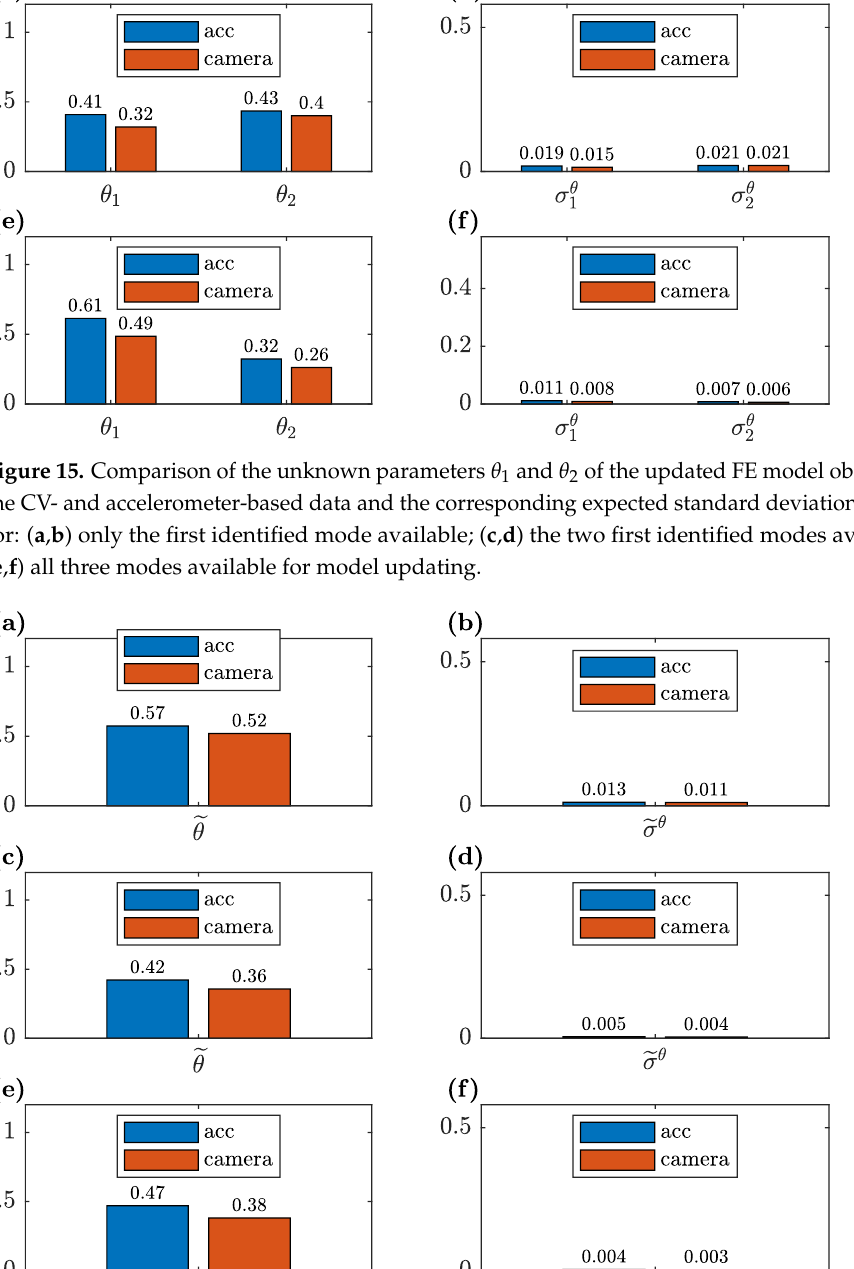
Figure 16. Comparison of the unknown parameter (cid:101) θ of the updated FE model obtained from the CV- and accelerometer-based data and the corresponding standard deviation (cid:101) σ θ for: ( a , b ) only the first identified mode available; ( c , d ) the two first identified modes available and ( e , f ) all three modes available for model